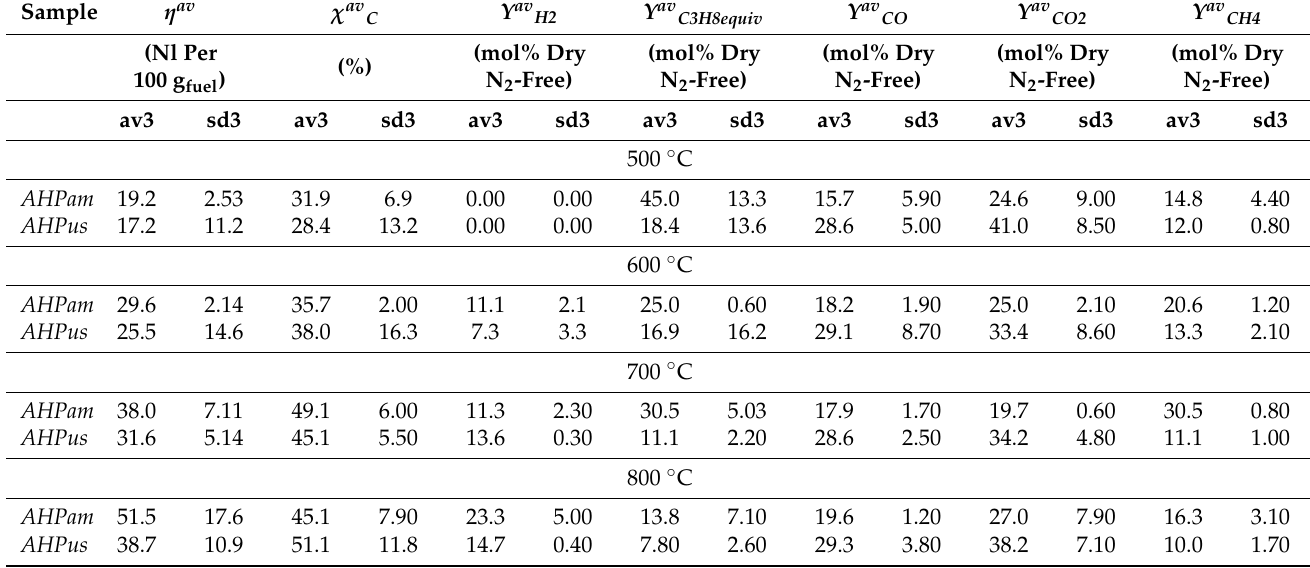
Table A2. Experimental results of devolatilization tests under nitrogen plus air atmosphere, as functions of temperature (av3: average of results from the three individual pellets; sd3: standard deviation of results from the three individual